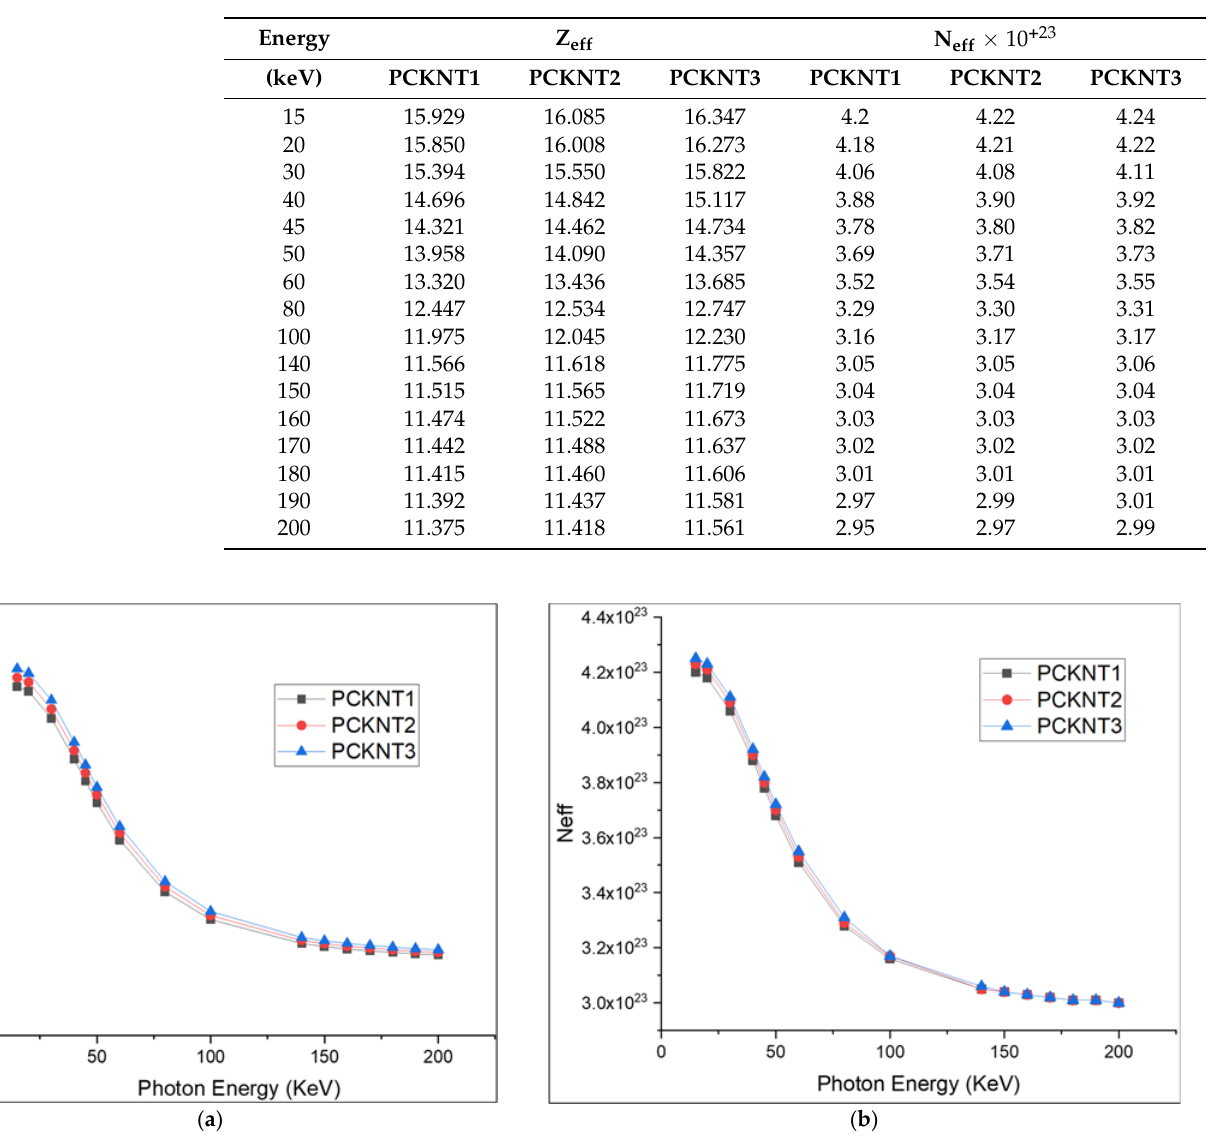
Table 6. Effective atomic number and effective electron density for PCKNT glasses.